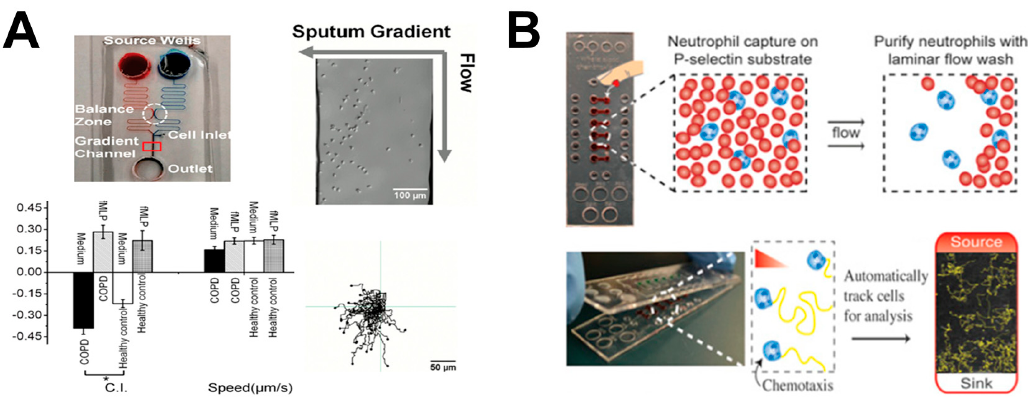
Figure 3. Examples of lung-on-chip cell migration study. ( A ) Microfluidics-based approach for investigating neutrophil chemotaxis with clinical samples for rapid diagnosis of COPD. The upper-left panel illustrates the microfluidic device; the upper-right panel shows a representative cell image in the device; the bottom-left panel shows cell migration test data using the microfluidic device (C.I.: chemotactic index); the bottom-right panel shows cell tracks from a representative experiment. ( B ) Microfluidics-based approach for investigating neutrophil chemotaxis with clinical samples for asthma detection. The upper panel illustrates rapid on-chip neutrophil isolation from blood; the bottom panel illustrates the microfluidic method for neutrophil chemotaxis test. Figure 3A was adapted from reference [26] with permission from PLOS; Figure 3B was reproduced from reference [27]